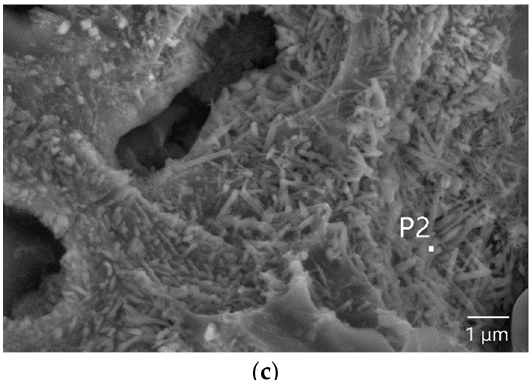
Figure 2. Morphology of the outer surface of sample DL-1: ( a ) OM image, showing the naked body at the local spalling position of the glaze; ( b ) SEM image, showing the rod-like anorthite crystals in the body/glaze interlayer exposed from the breakage of the glaze; and ( c ) SEM image, showing the sill-like crystal clusters composed of mullite crystals.